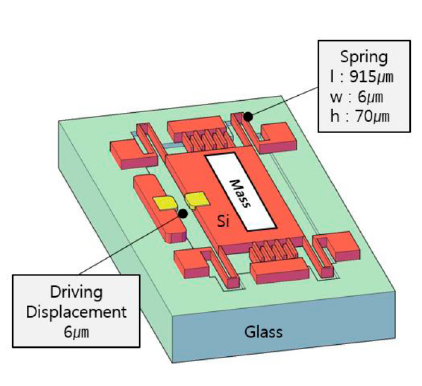
Figure 1. Schematic of MEMS inertial switch.